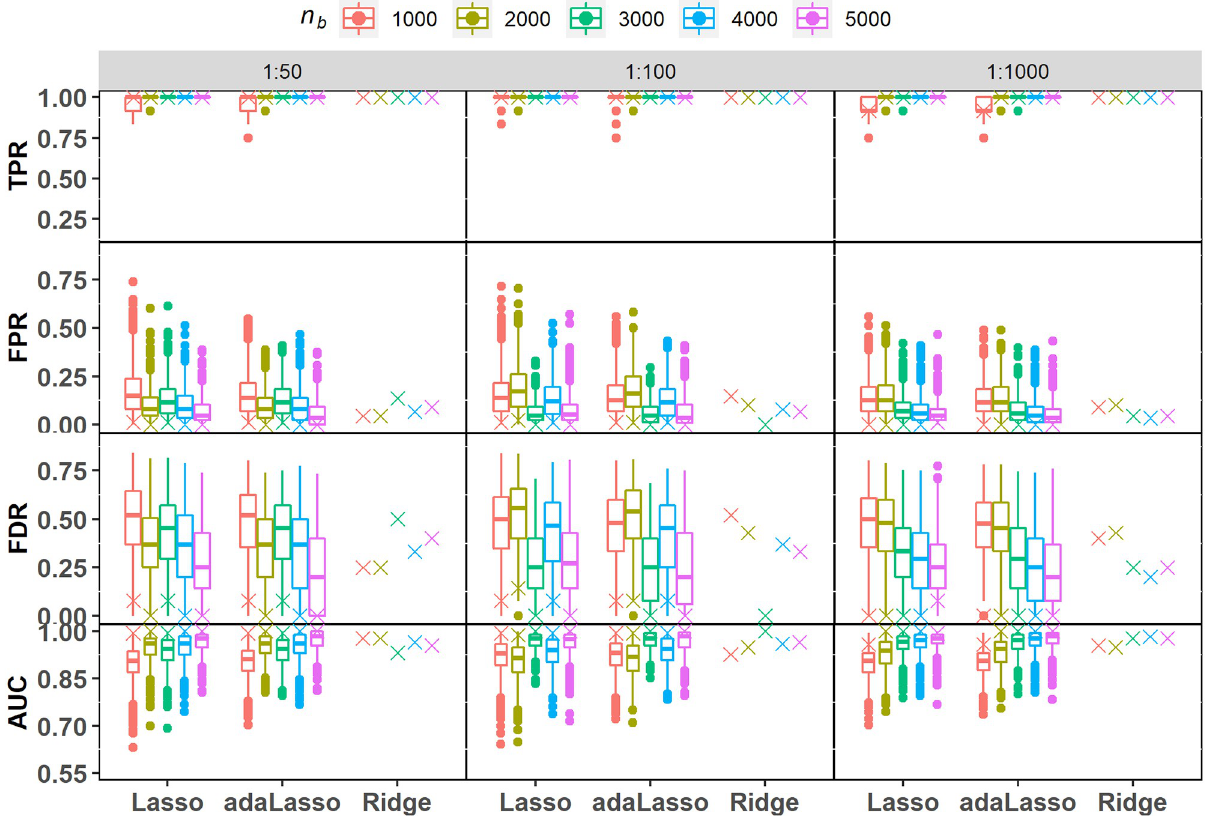
Fig 3. Simulation under UNCOR-12. Performance metric scores for variable selection based on the SVRS algorithm (symbol x) and corresponding distributions across 500 individual fits of each regularization model with imbalance ratios 1:50, 1:100 and 1:1000. Performance scores for individual ridge regression fits are not applicable as it does not perform automatic variable